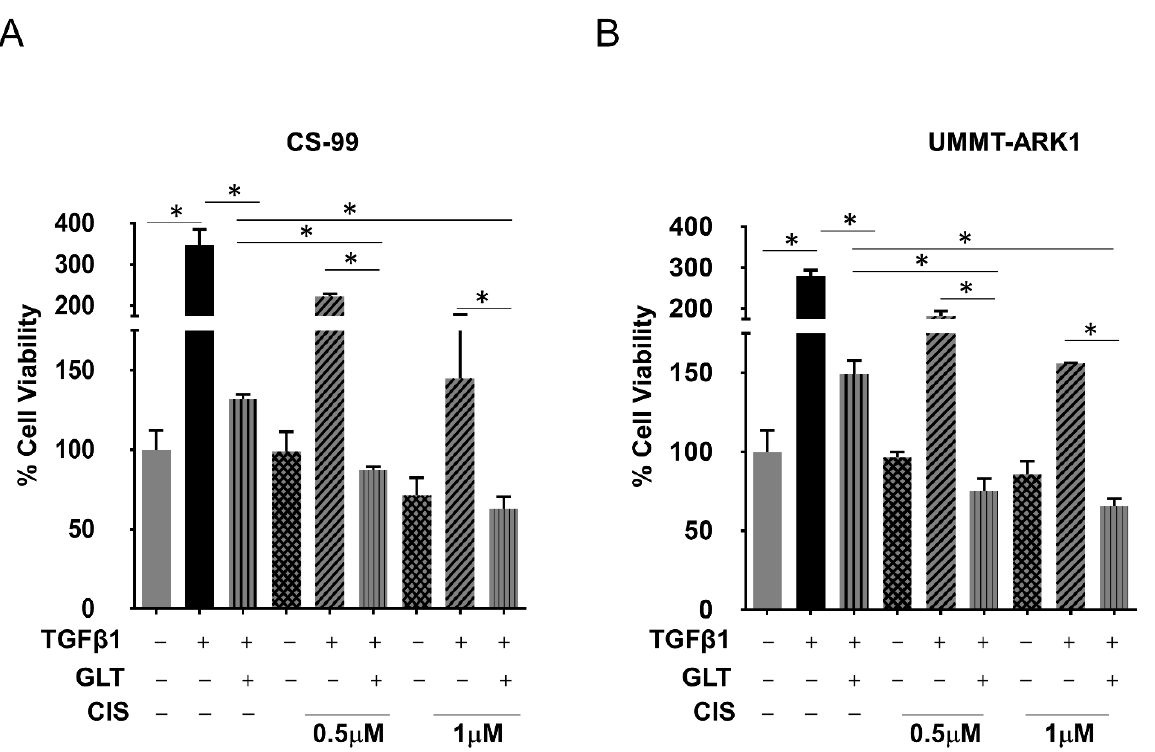
FIGURE 2: TGFβ1 in UCS cell proliferation and cisplatin sensitivity. (A) CS-99 and (B) UMMT-ARK1 cells were grown in Matrigel and treated as represented, post 72h treatment cell viability was evaluated using CellTiter-Glo® Luminescent Cell Viability Assay (Promega) and % cell viability compared to Vehicle (V) treated control is plotted. Data are mean ± SD of three independent experiments performed in triplicate. *, P <